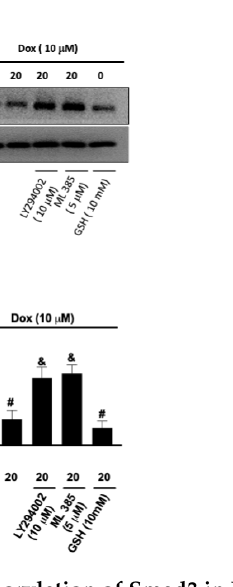
Figure 4. Phosphorylation of Smad3 in Dox-treated cells. Representative Western blot images ( A ) and densitometric analysis ( B ) of phospho-Smad3 and total Smad3 in H9c2 cells exposed to Dox stimulation with or without DAPA treatment were shown. LY294002 (a PI3K inhibitor), ML385 (a Nrf2 inhibitor), and GSH (an antioxidant) were used in some experiments. Results are shown as means ± SD of three independent experiments. Statistical analysis was performed using one-way ANOVA with a Bonferroni post hoc test. [* p < 0.05 compared to the control group; # p < 0.05 com- pared to the Dox-only group; & p < 0.05 compared to Dox + DAPA group].